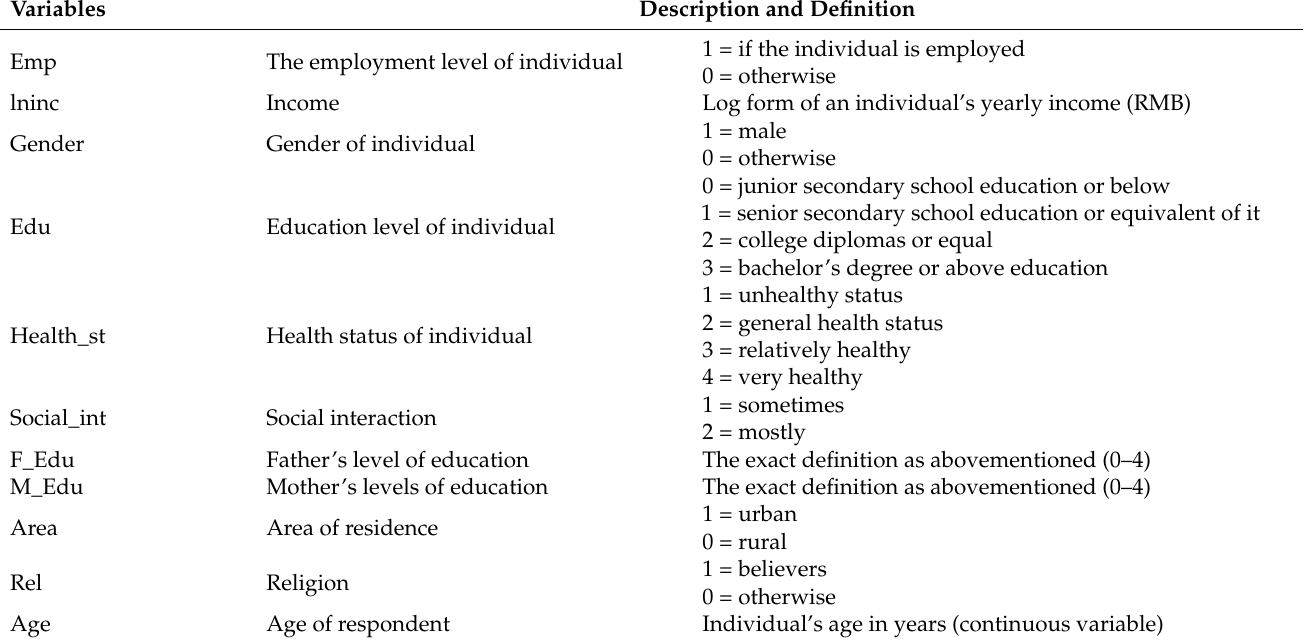
Table 1. Description and definition of